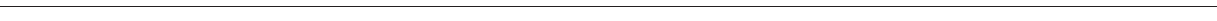
FIGURE 11 | without CPZ ( n = 7–10; p < 0.05; unpaired tested). (D) Time course recording showing the current increases induced by 10ng/ml VEGF and current density levels after adding AMTB (20 µ M). (E) Original traces of VEGF-induced current responses to voltage ramps. Current densities are shown before application (labeled as A), during application of VEGF (labeled as B), and after addition of AMTB (labeled as C). Current densities as function of voltage were derived from the traces shown in (D) . (F) Summary of the experiments with VEGF and AMTB. Same statistical analyses as those described in (C) but with AMTB instead of CPZ ( n = 9; * p < 0.01; # p < 0.05). (G) Menthol (500 µ M) induced a Ca 2 + increase ( n = 6) whereas non-treated control cells showed a constant Ca 2 + baseline ( n = 6). (H) Same experiments as shown in (G) , but with 3-T 1 AM (1 µ M) ( n = 6). (I) Summary of the experiments with menthol and 3-T 1 AM. The asterisks (*) designate significance in [Ca 2 + ] i with menthol ( n = 6; ** p < 0.01) or with 3-T 1 AM ( n = 6; * p = 0.05; both paired